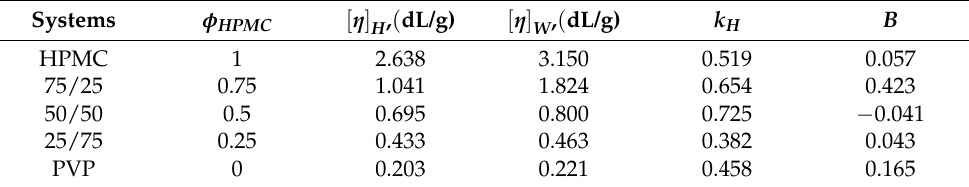
Table 7. Viscometric parameters obtained by Huggins and Wolf equations for HPMC/PVP polymers mixture in water at 25 ◦